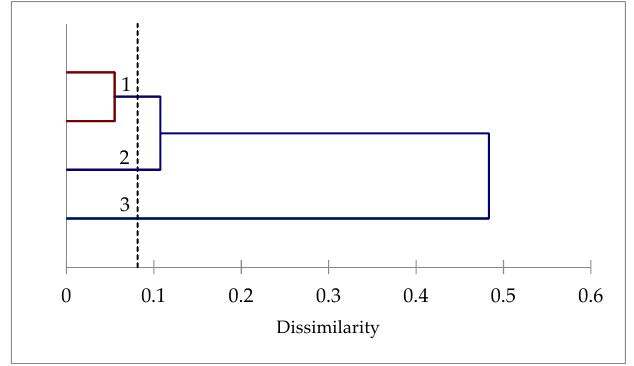
Figure 6. Dendrogram of M. truncatula lines based on Euclidean distances of the dissimilarity matrix using Ward’s method.